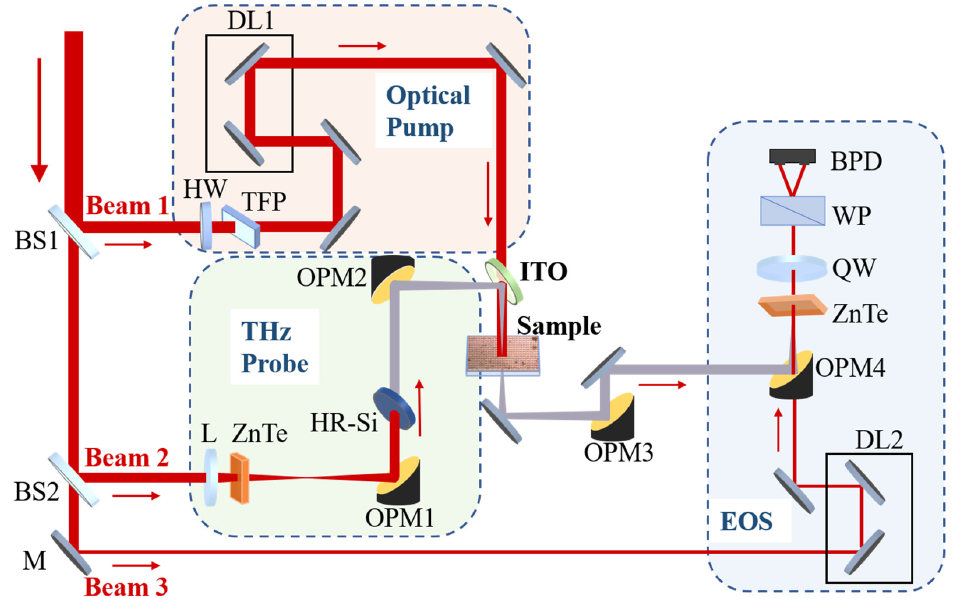
Figure 2. Schematic representation of the experimental setup. BS1 and BS2, beam splitters; M, mirror; L, lens; ZnTe, zinc telluride electro-optic crystal; OPM1-4, off-axis parabolic mirrors; HR-Si, high-resistivity silicon plate; ITO, indium tin oxide transparent conductive film glass; HW, half-wave plate; TFP, thin film polarizer; DL1 and DL2, delay lines; QW, quarter-wave plate; WP, Wollaston prism; BPD, balanced photodiodes.